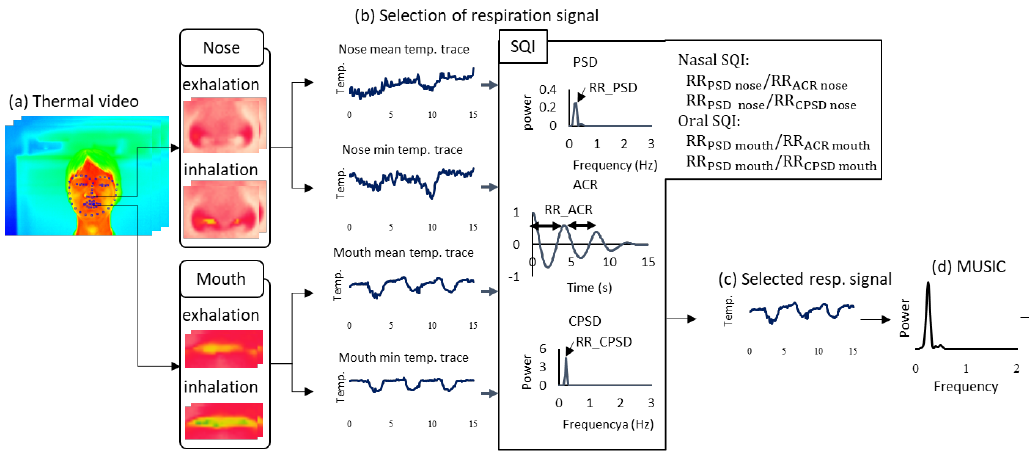
Figure 5. Block diagram of signal processing for respiration rate (RR) estimation. ( a ) Thermal video frame with facial landmark detected by the fusion sensor system described in Section 2. ( b ) Time-series data extracted from nasal and oral areas. ( c ) Respiration signal that chooses from four signals (b) based on SQI. ( d ) Power spectra obtained by MUSIC.